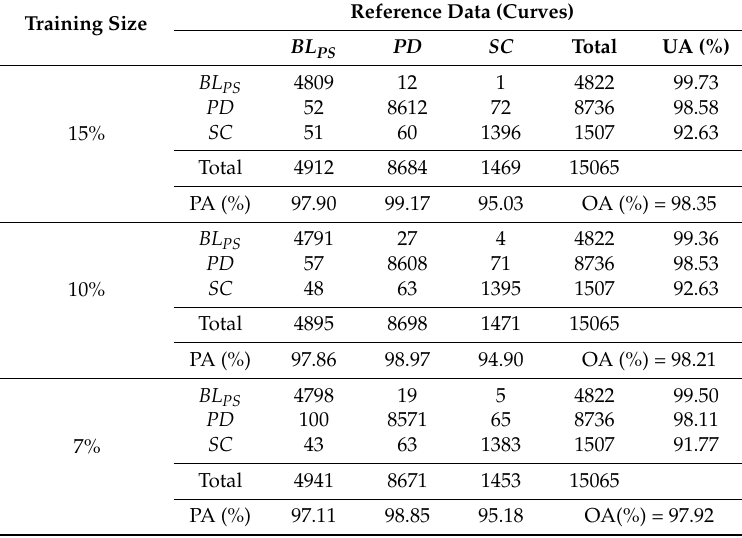
Table 5. Error matrix table of PS